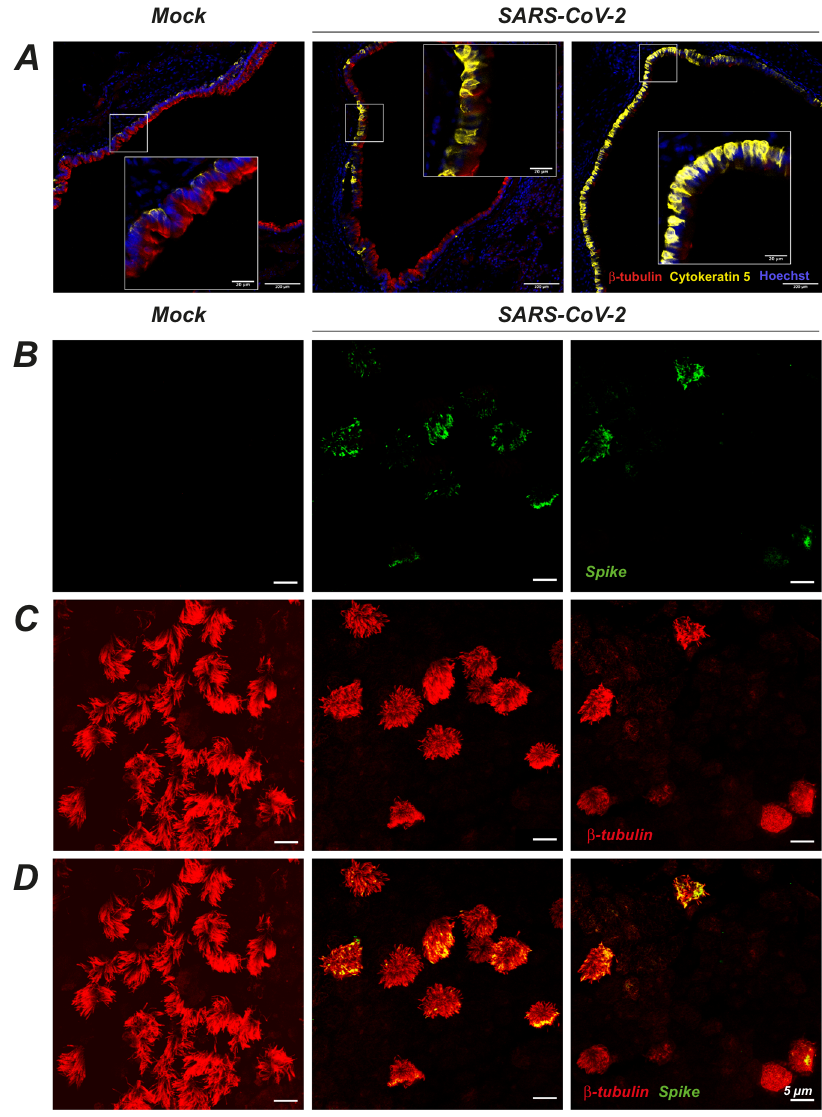
Fig. 8 SARS-CoV-2 infection targets ciliated cells in the trachea of infected Syrian golden hamsters. A Immuno fl uorescence imaging of hamster tracheas at 4 dpi. Ciliated cells are labeled with β -tubulin IV (red), basal cells by cytokeratin-5 (yellow), and nuclei by Hoechst (blue). Representative images are shown for a mock-infected animal (left, n = 3), and SARS-CoV-2-infected animals who received a low dose (middle, n = 2) or a high dose (right, n = 2) of virus. B – D Whole-mount immuno fl uorescence imaging of the tracheal epithelium of mock-infected (left) or SARS-CoV-2-infected (middle and right) hamsters at 4 dpi. Labeling for the SARS-CoV-2 spike ( B , green), the ciliated cell marker β -tubulin IV ( C , red), or both markers ( D ) are shown. The tracheal epithelium obtained in the infected animal show various degrees of cilia destruction (middle, right) depending on the